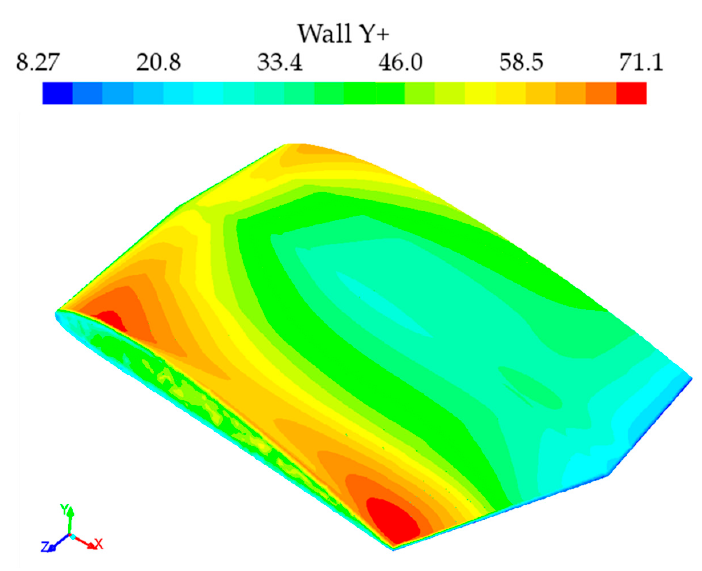
Figure 3. Wall y + visualization on the compound wing. Figure 3. Wall y+ visualization on the compound wing.